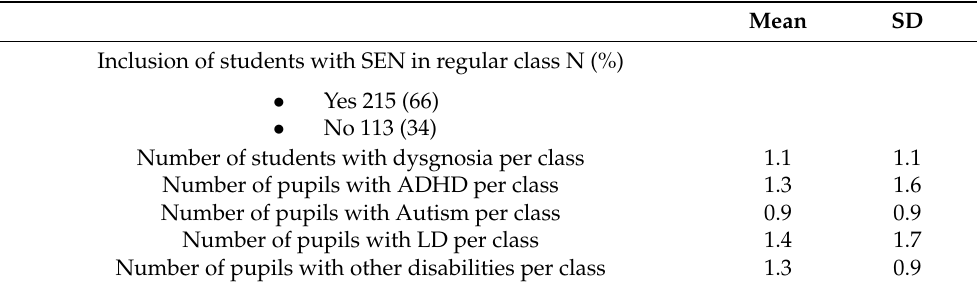
Table 2. Inclusion of pupils with SEN in regular EFL classes.